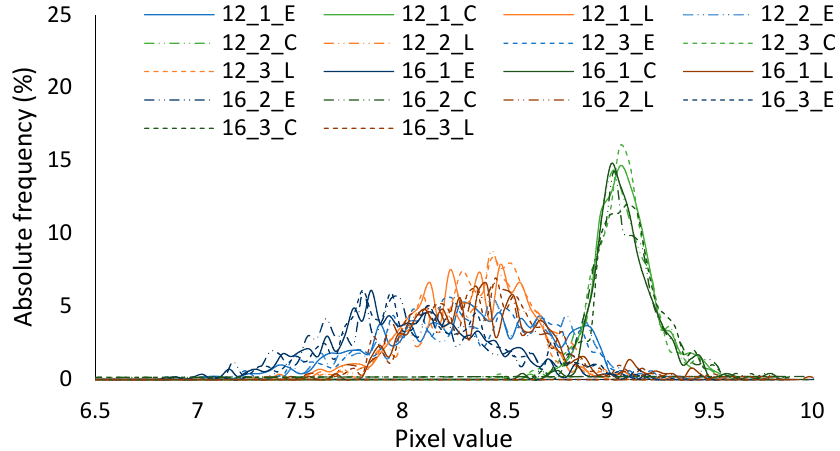
Figure 8. Histograms for each one of the crop lines and the six studied images. Table 4. Summary of ANOVA results with the mean values of selected areas.